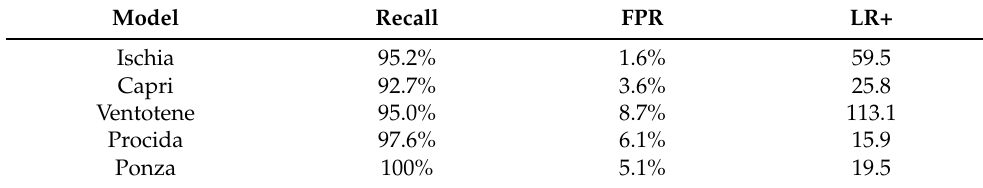
Table 5. The results with a threshold at